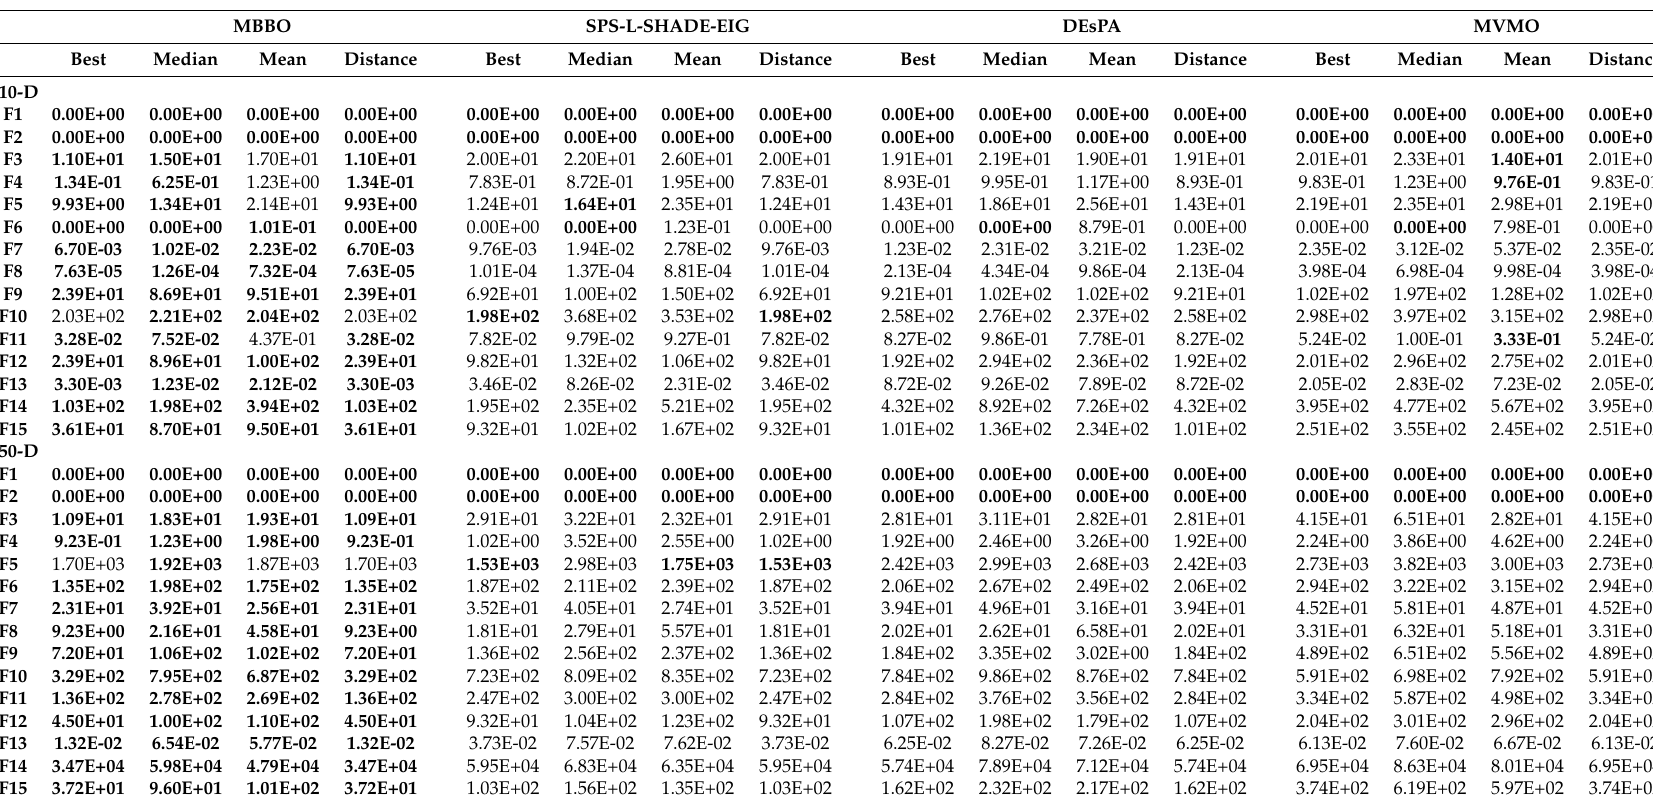
Table 2. Comparison of MBBO, SPS-L-SHADE-EIG, DEsPA and MVMO. Statistical results of the 10-D and 50-D benchmark functions, averaged over 100 independent